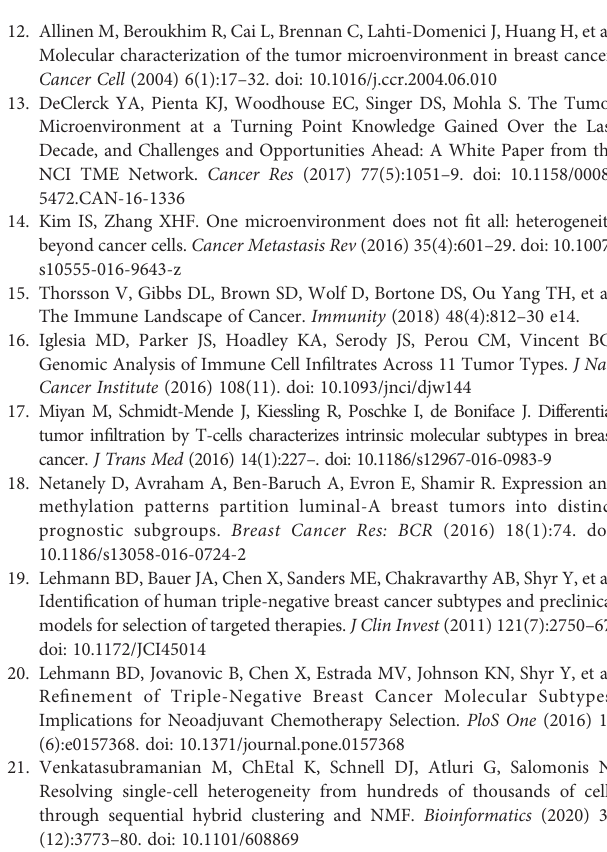
SUPPLEMENTARY FIGURE 1 | Kaplan-Meier survival analysis of NR2E1, INGX, C1QL2, POU5F1, A2ML1, ROPN1, VGLL1, FZD9 using Breast Cancer Gene- Expression Miner v4.0